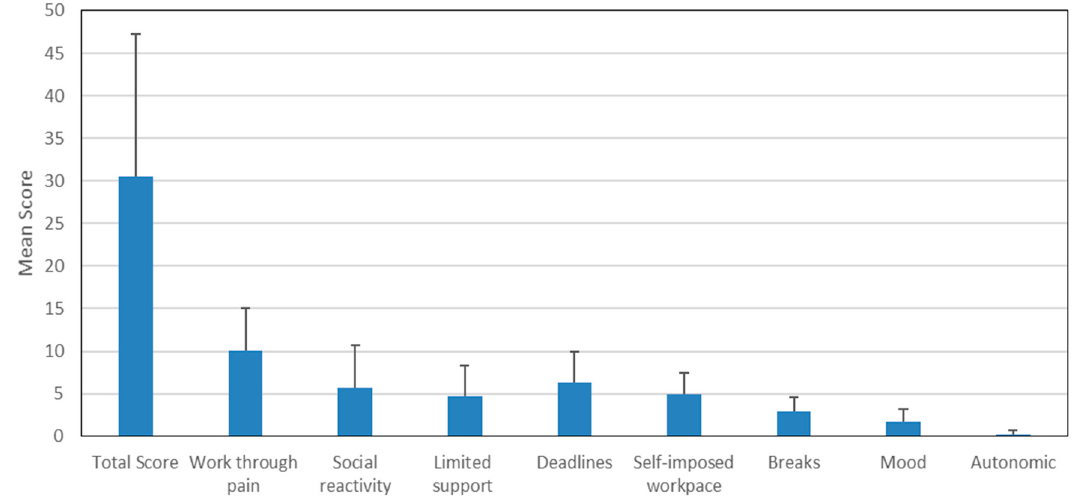
Figure 2 . Workstyle total and subscale scores in participants ( n = 285). Figure 2. Workstyle total and subscale scores in participants ( n = 285).